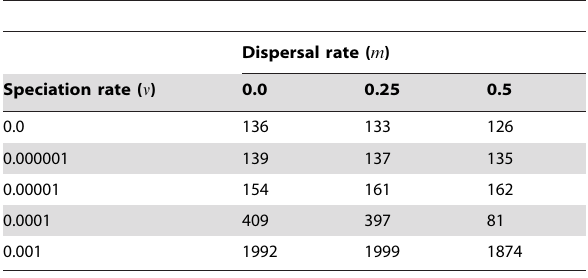
Table 1 . Species richness in neutral model simulations with different rates of speciation and dispersal.